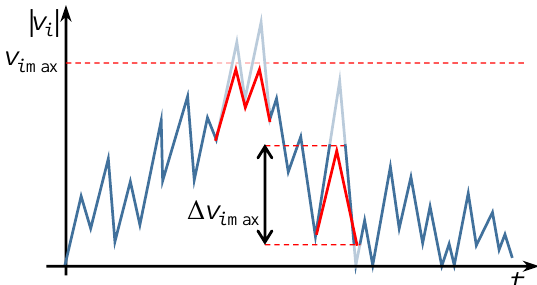
Figure A4. Representation of the presented saturation filter on velocity estimates in i th direction; blue shows the original EKF estimate and red shows the correction. Note that the measurements are discrete and represented by the peaks; the linear interpolation between measurements is only for visualisation